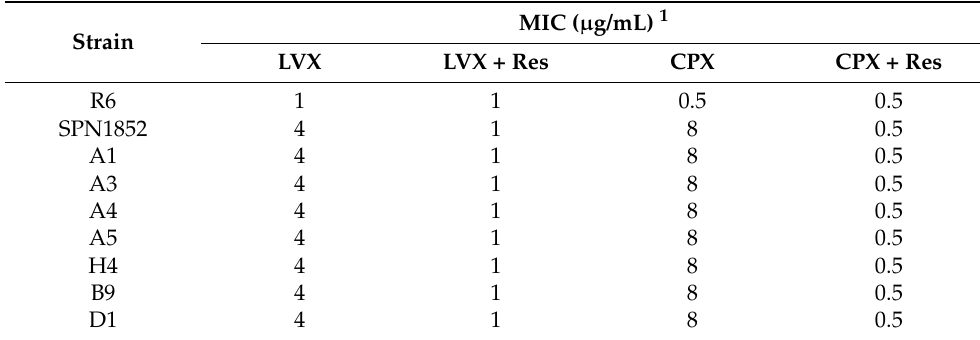
Table 1. Susceptibilities to FQs of SPN chromosomal transformants determined by blood–agar plate in the presence or in the absence of 20 µ g/mL of Res, compared to R6 and SPN1852. MIC ( µ g/mL) 1 Strain LVX LVX + Res CPX CPX + Res